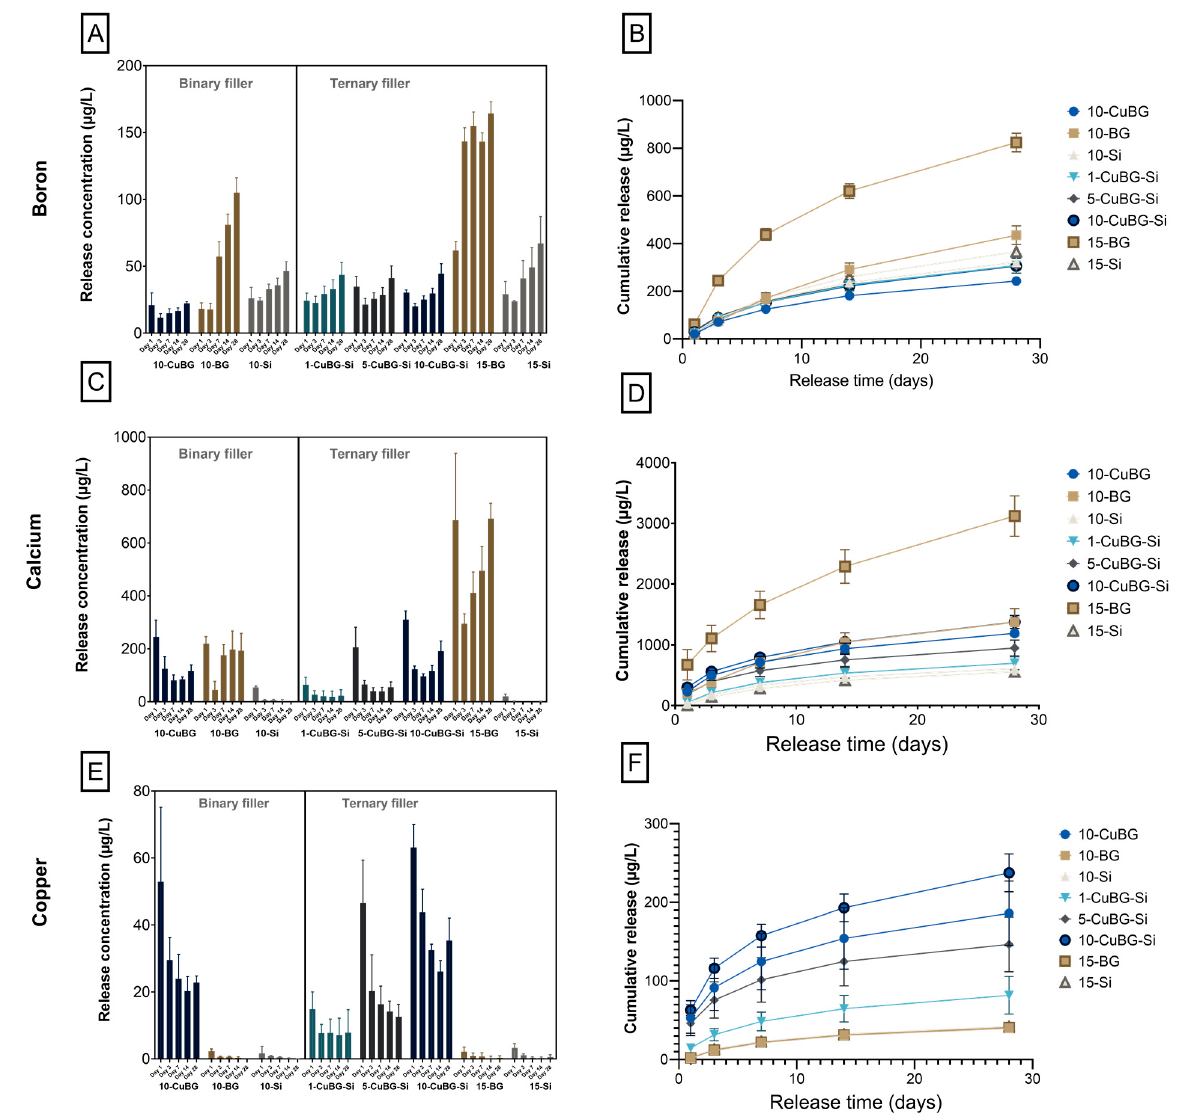
Figure 9. The ion release profile of the Binary filler and Ternary filler groups over 28 days. ( A ) The concentration of boron ion released, ( B ) cumulative concentration of boron ion released, ( C , D ), concentration of calcium ion released, and ( E , F ) concentration of copper ion released. All the samples were immersed in HEPES buffer (pH = 6.5). Three samples from each group (n = 3) were used for analysis. Data presented as mean values with error bars representing standard deviations (significance levels not shown for display